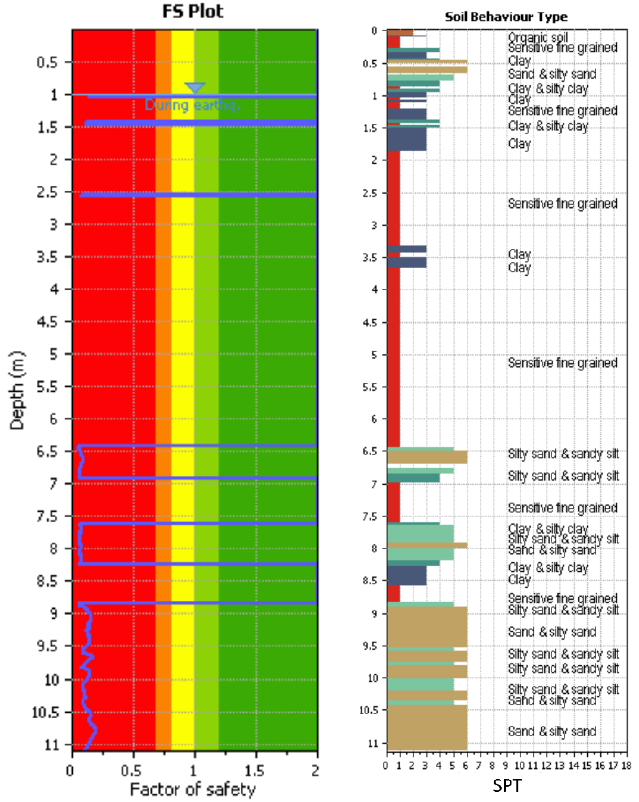
Figure 18. CPT liquefaction triggering results and SBT plot for Site 1 (modified from Anderson [40]).